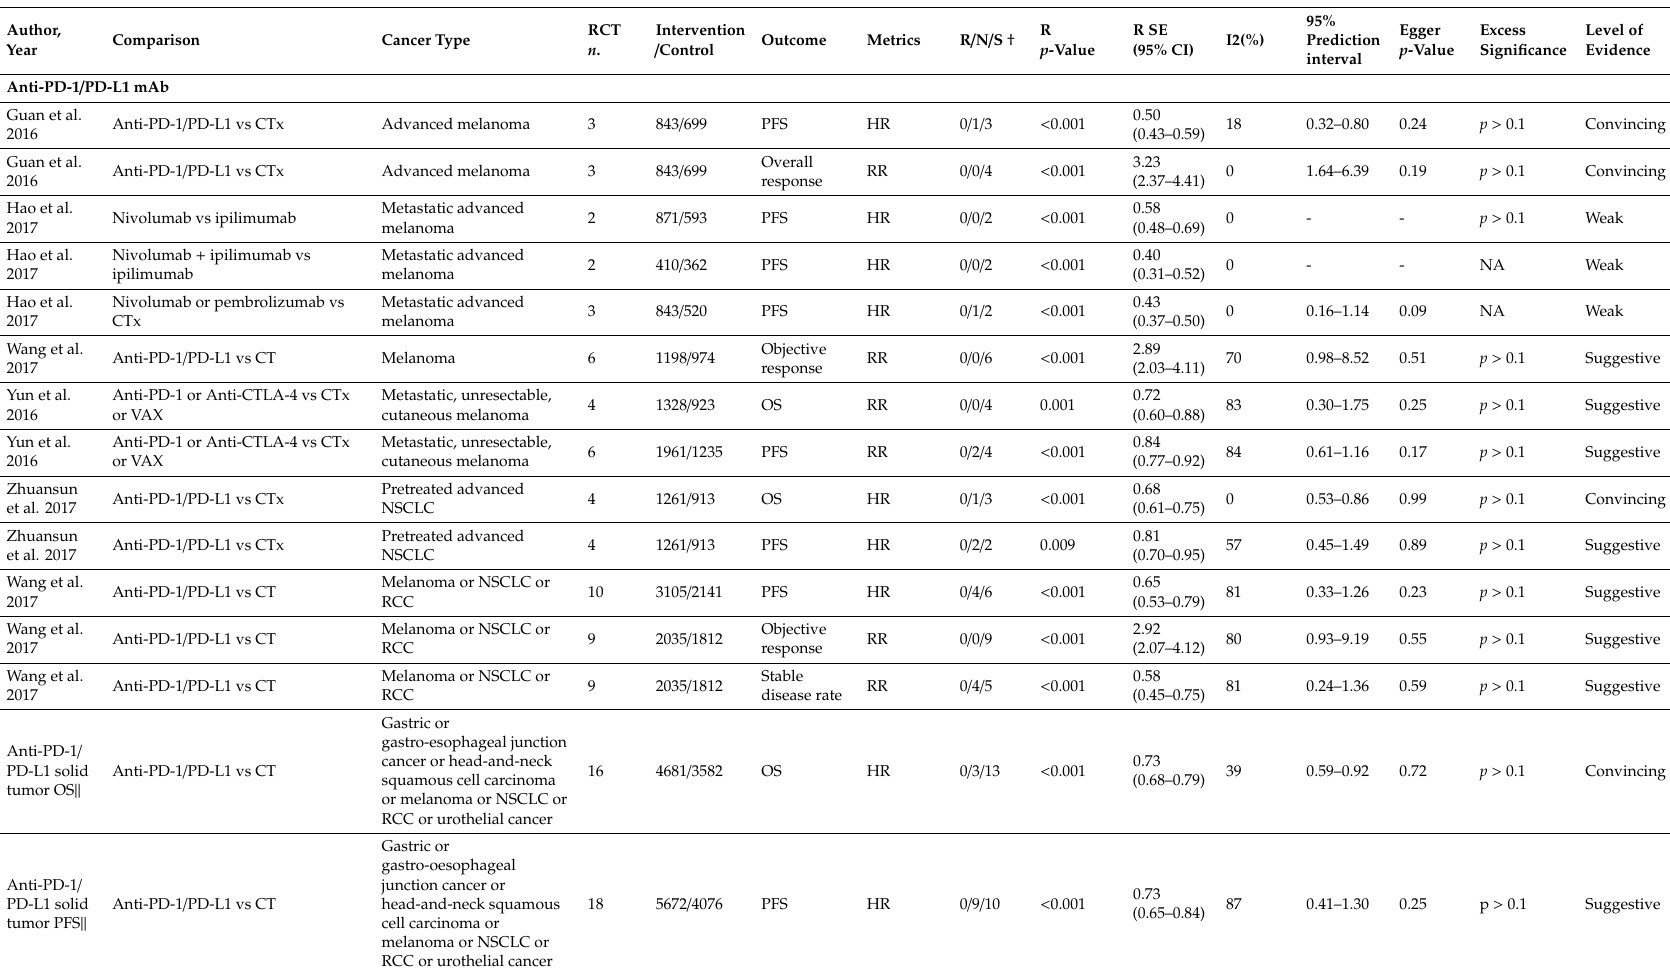
Table 1. Main findings and level of evidence reported in meta-analyses of cancer therapeutic anti-PD-1 / PD-L1 and anti-CD20 monoclonal